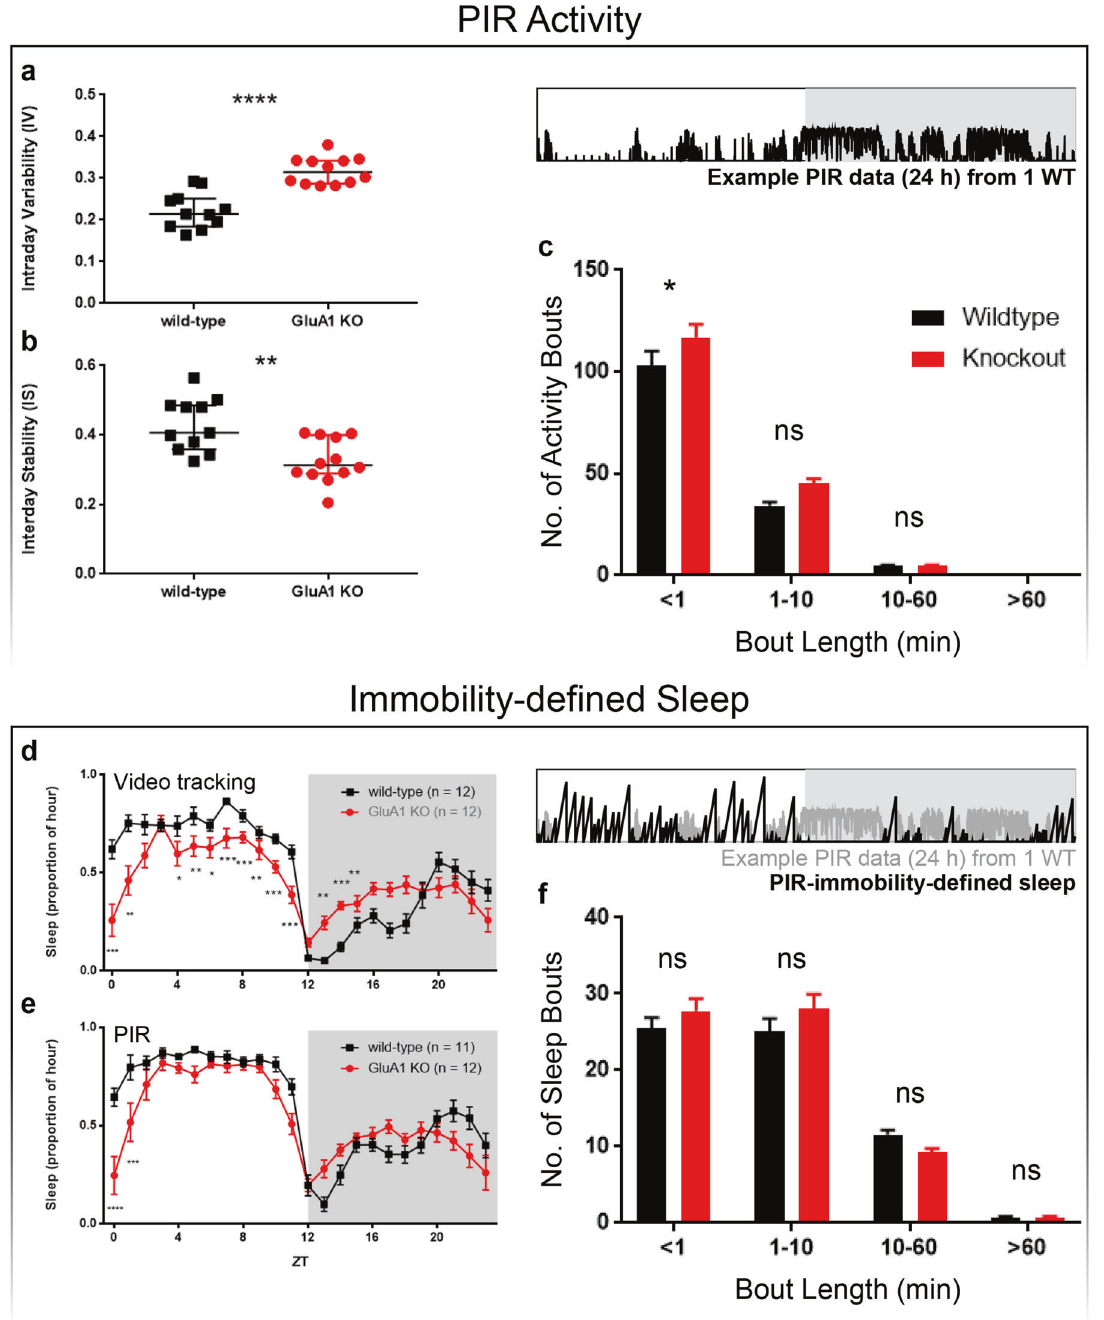
Fig. 2 PIR activity bouts and immobility-de fi ned sleep. a – c PIR activity. An example PIR recording (24 h) from one animal is shown in the black trace. a Interday stability (IS) of PIR activity, from seven days of 12:12 LD activity data. b Intraday variability (IV) of PIR activity, from the same seven days of 12:12 LD activity data. c Numbers of short (<1 min) and long PIR activity bouts ( ≥ 1 min) observed in wild-type ( n = 11) and GluA1 KO ( n = 12) mice from PIR data over seven days of 12:12 LD. GluA1 knockouts showed more short activity bouts (<1 min) than wild-type mice. d – f Behavioural sleep. An example PIR recording (24 h) is shown in the grey trace and PIR-immobility-de fi ned sleep is shown in the black trace. d Behavioural sleep extracted from video-tracking data: 24-h distribution of average hourly proportion of sleep over three non- sequential days of 12:12 LD, as de fi ned by ≥ 40 s of immobility under video tracking. e Behavioural sleep extracted from PIR data: 24-h distribution of average hourly proportion of sleep over 7 sequential days of 12:12 LD, as de fi ned by ≥ 40 s of PIR inactivity. f Numbers of short (<1 min) and long immobility-de fi ned sleep bouts ( ≥ 1 min) observed in wild-type ( n = 11) and GluA1 KO ( n = 12) mice from PIR data over seven days of 12:12 LD. **** p ≤ 0.0001; *** p ≤ 0.001; ** p ≤ 0.01; * p < = + 5.70%, p = 0.023). By contrast, sharper and exaggerated 1.384, p = 0.267]. More speci fi cally, in wild-type animals only small responses to dusk and dawn were found in GluA1-knockout and gradual changes in locomotor activity were observed at dusk animals (10 s before vs. 10 s after dusk: mean Δ activity = + 9.30%, and dawn (10 s before vs. 10 s after dusk: mean Δ activity = + 3.84%, p = 0.169; 10 s before vs. 10 s after dawn: mean Δ activity p = 0.02; 10 s before vs. 10 s after dawn: mean Δ activity = + 9.63%,